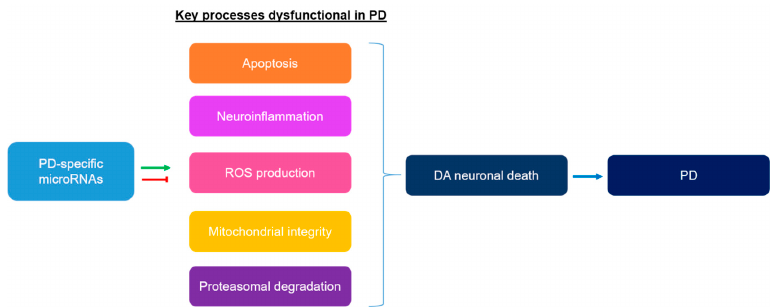
Figure 1. Key processes that are dysfunctional in Parkinson’s disease (PD) and could be regulated by a group of PD-specific differentially expressed miRNAs.